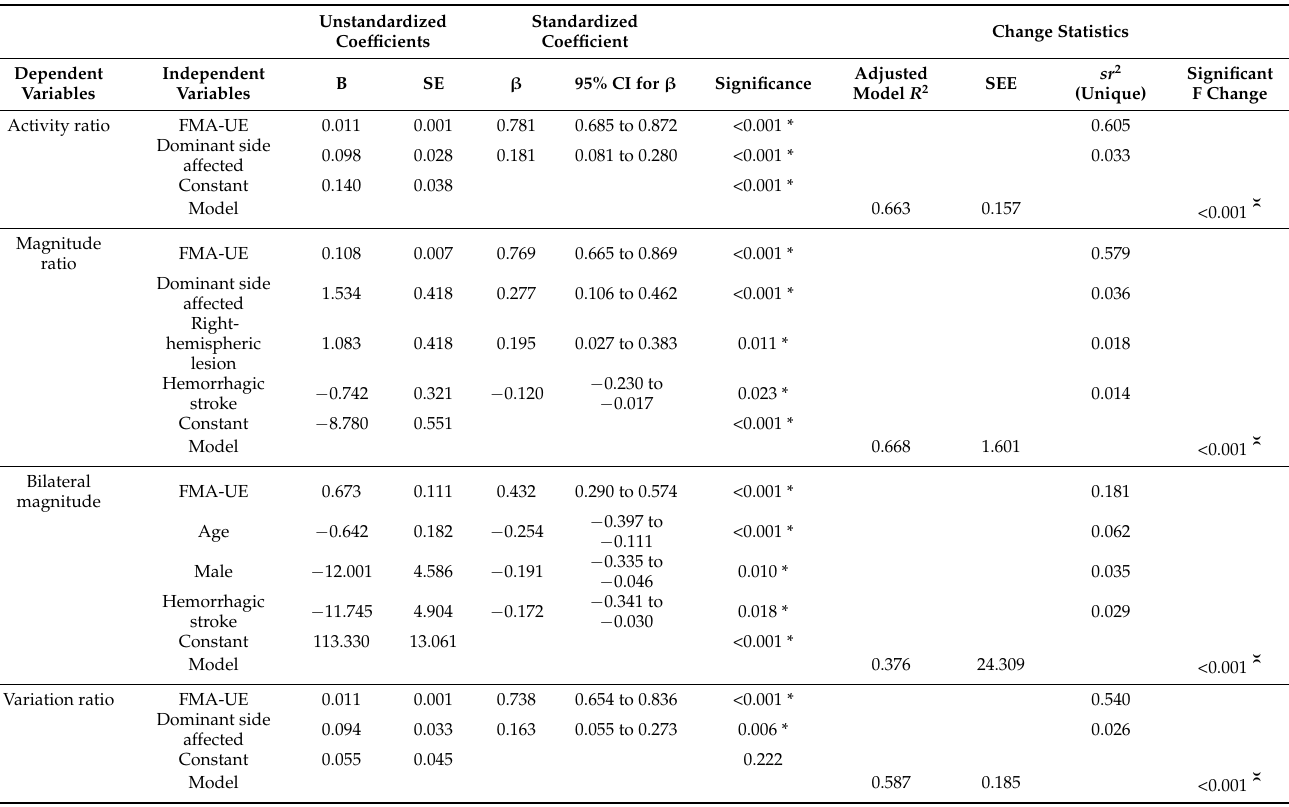
Table 3. Standard multiple regression models to examine the association between various indepen- dent factors and different sensor